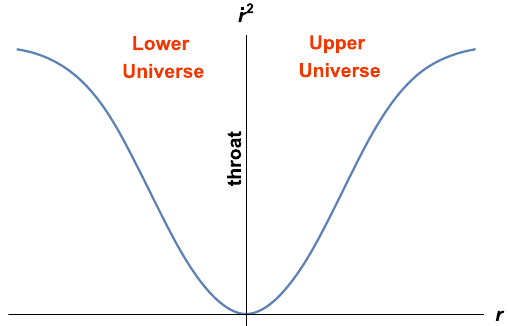
Fig. 5 A representation of ˙ r 2 vs. r near the throat. The coordinate discontinuity at the throat is